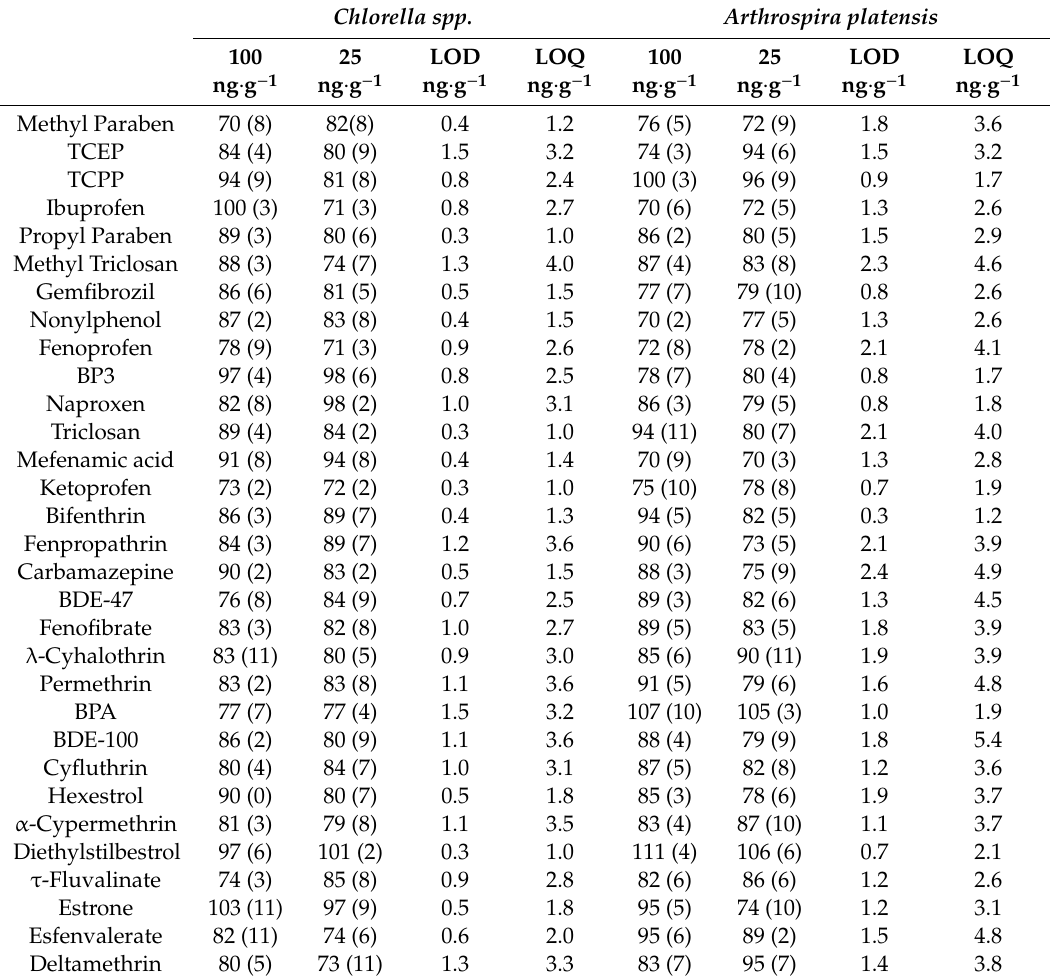
Table 2. Recoveries (%) and relative standard deviations (RSD ( n = 4), % in parenthesis), limits of detection (LOD) and limits of quantification (LOQ) ( n = 10) obtained for target compounds in chlorella and